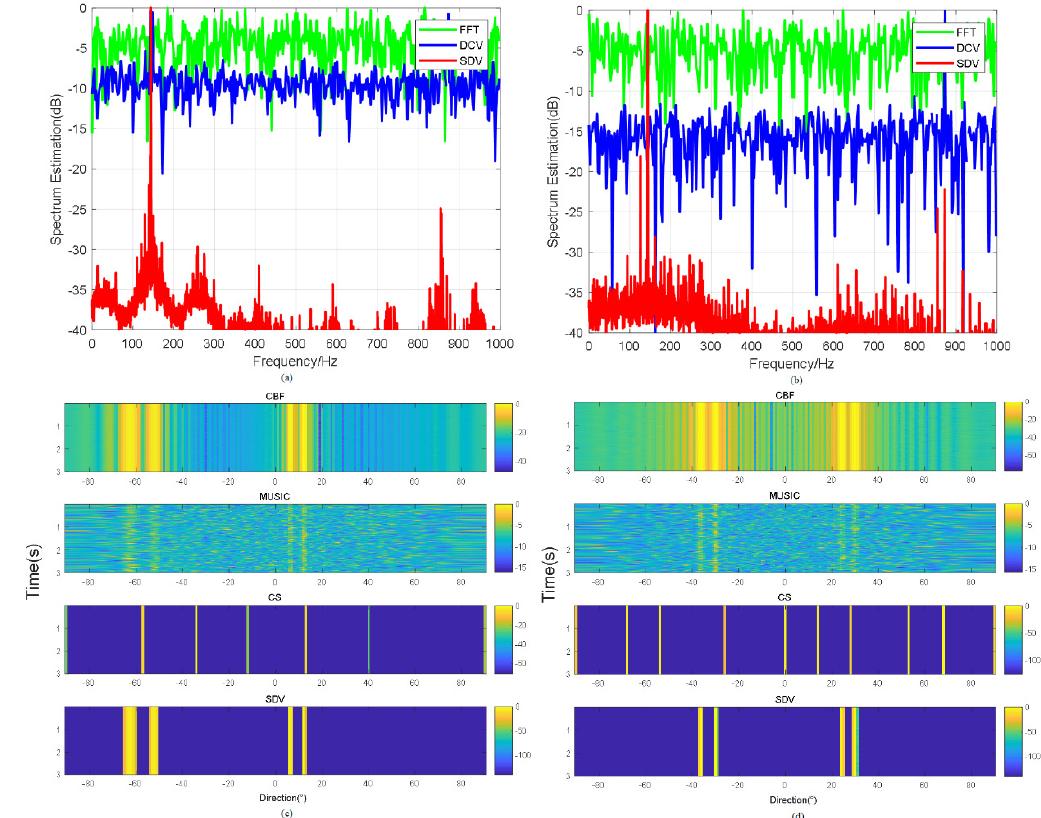
Figure 10. Comparison of FFT, DCV and proposed pre-process of SDV in first set of data as shown in ( a ) and the second set of data as shown in ( b ); Comparison of direction estimation obtained through CBF, MVDR, CS and SDV in experiment with the first set data: direction 1 = − 62 ◦ , − 57 ◦ ,7 ◦ ,11 ◦ as shown in ( c ) and the second set data: direction 1 = − 48 ◦ , − 30 ◦ ,22 ◦ ,31 ◦ as shown in ( d ). Table 3. Comparison of different beamforming methods under experimental data (a).